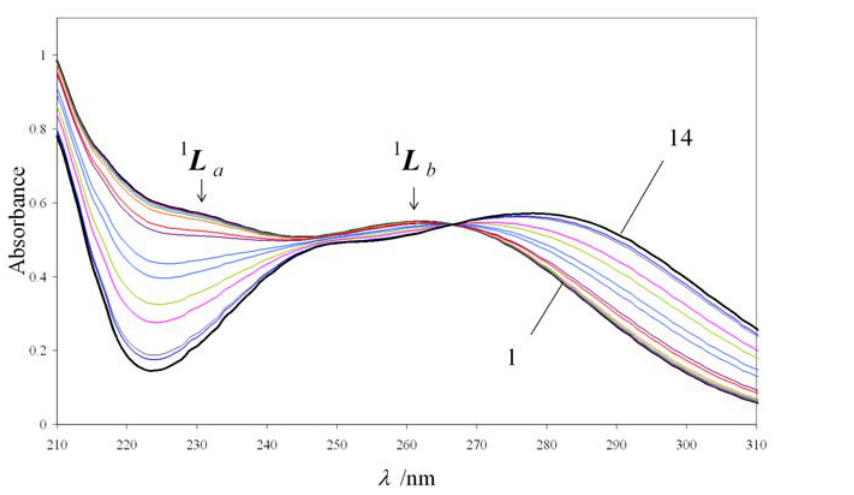
Fig. 3 Reconstructed absorption spectra of m -benzotoluidide as a function of sulfuric acid concentration from 0.5 (curve 1) to 15.0 mol dm − 3 (curve 14). similar to those reported previously for benzanilide